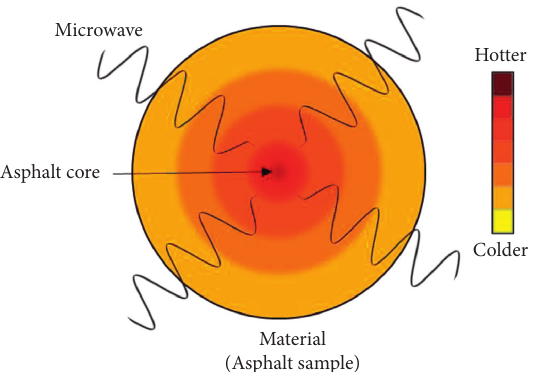
Figure 5: Phenomenon of heat generation in microwave heating [72].